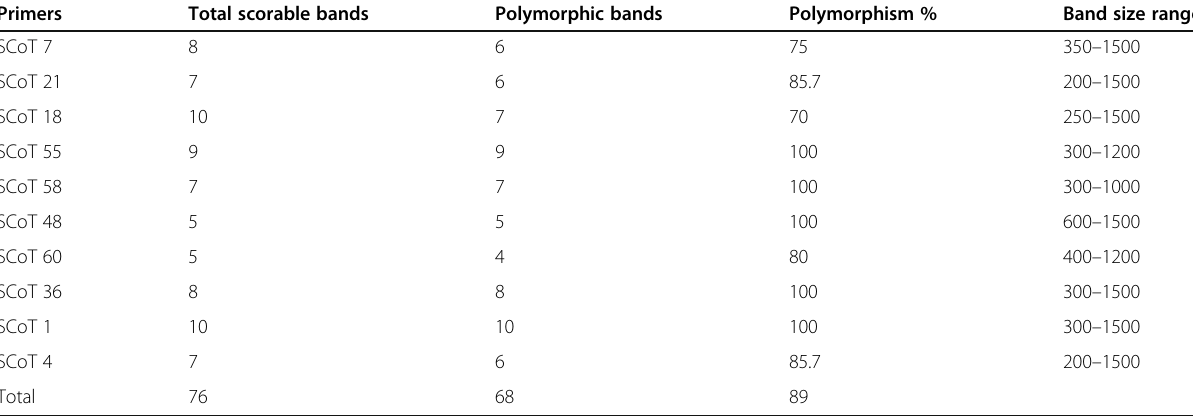
Table 3 Total number of scorable bands, polymorphism percentage, and band size of SCoT markers obtained by 10 primers Primers Total scorable bands Polymorphic bands Polymorphism